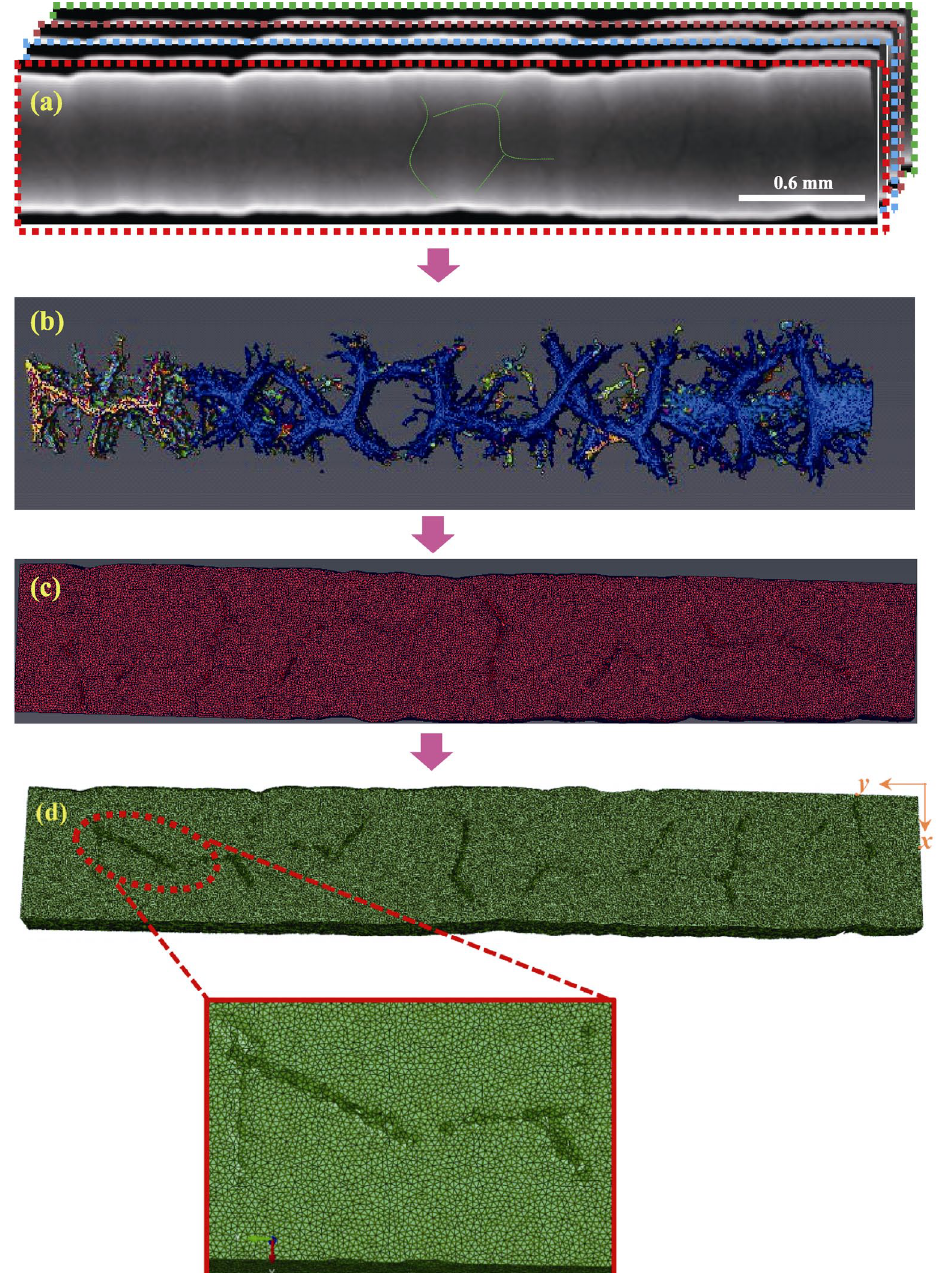
Fig. 4 Finite element modeling process of GYbZ coating with a commercial Avizo software: (a) The original images obtained from the X- ray μCT , (b) the internal true structure of GYbZ coating after the image processing, (c) superficial mesh processing of GYbZ coating sample, and (d) FEM meshes of GYbZ coating sample, where a representative region with dashed elliptical is enlarged, as shown in